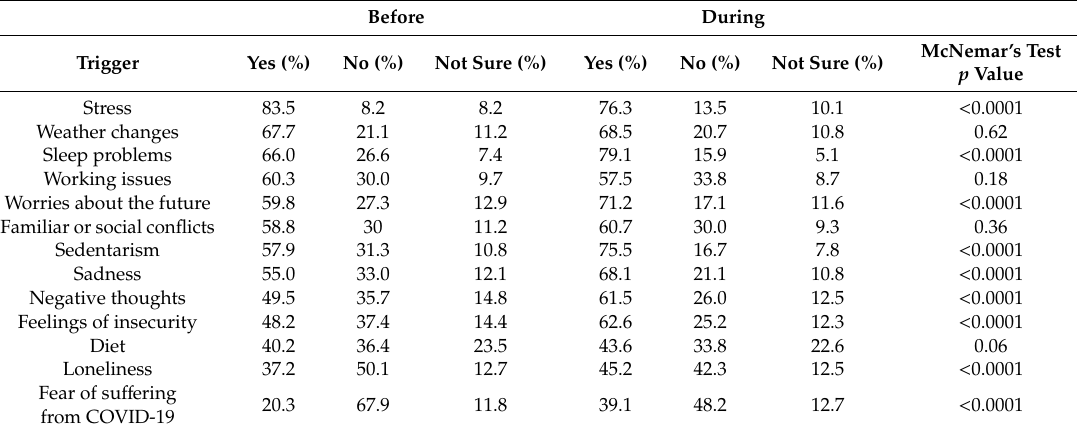
Table 5. Changes in perceived pain triggers before and during